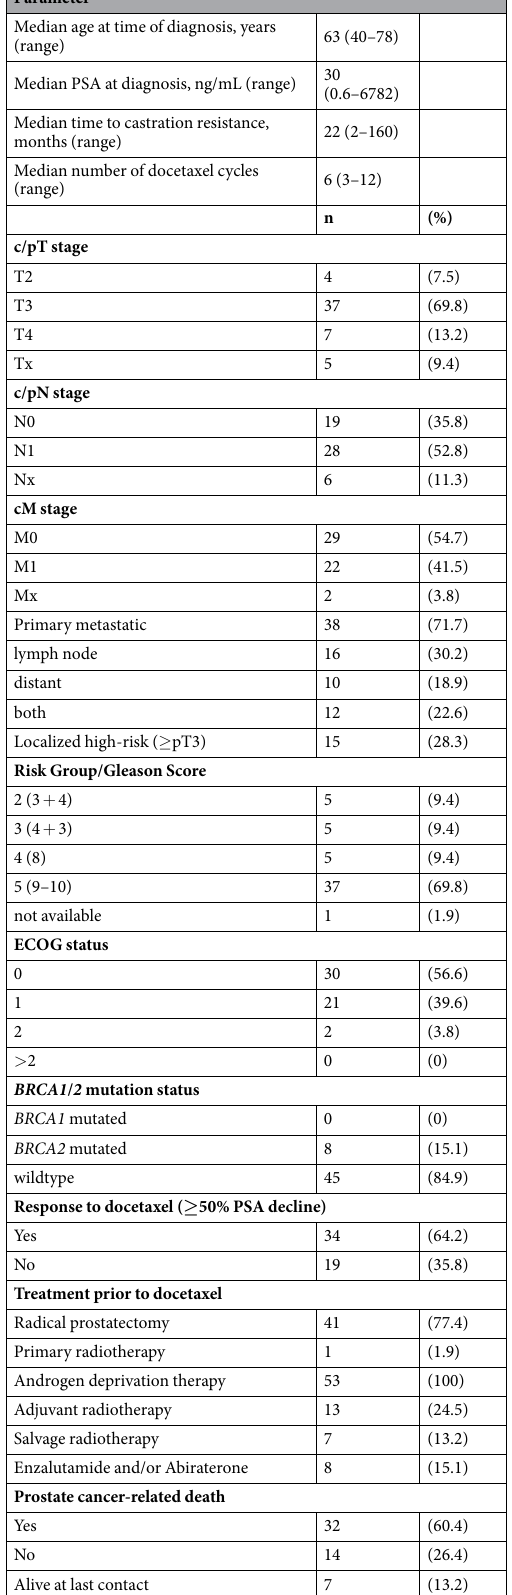
Table 1. Patient characteristics (n =